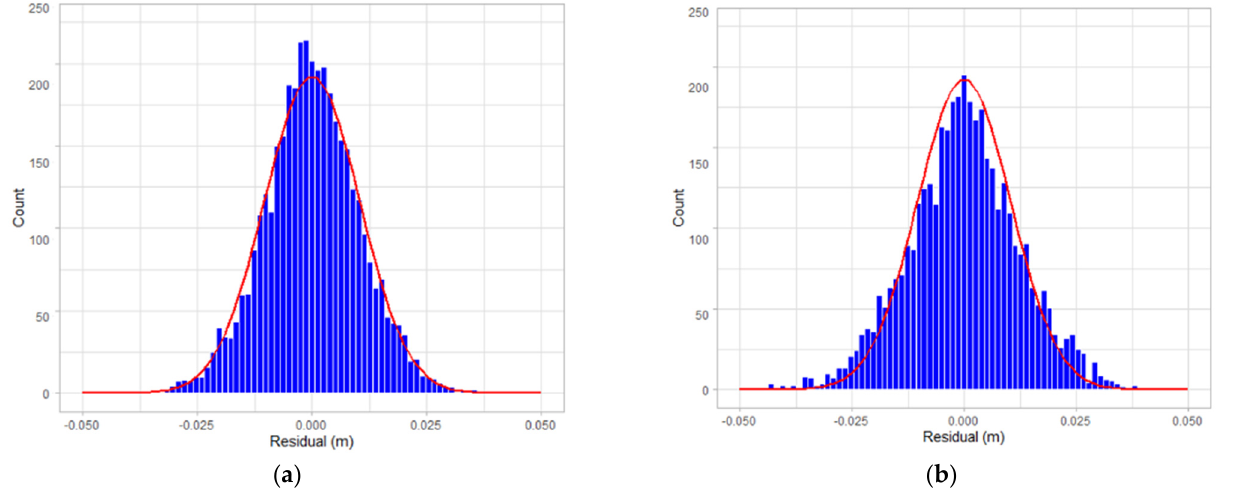
Figure 20. The residual distribution plots of dataset DATA2. ( a ) with Aps; ( b ) without Aps.